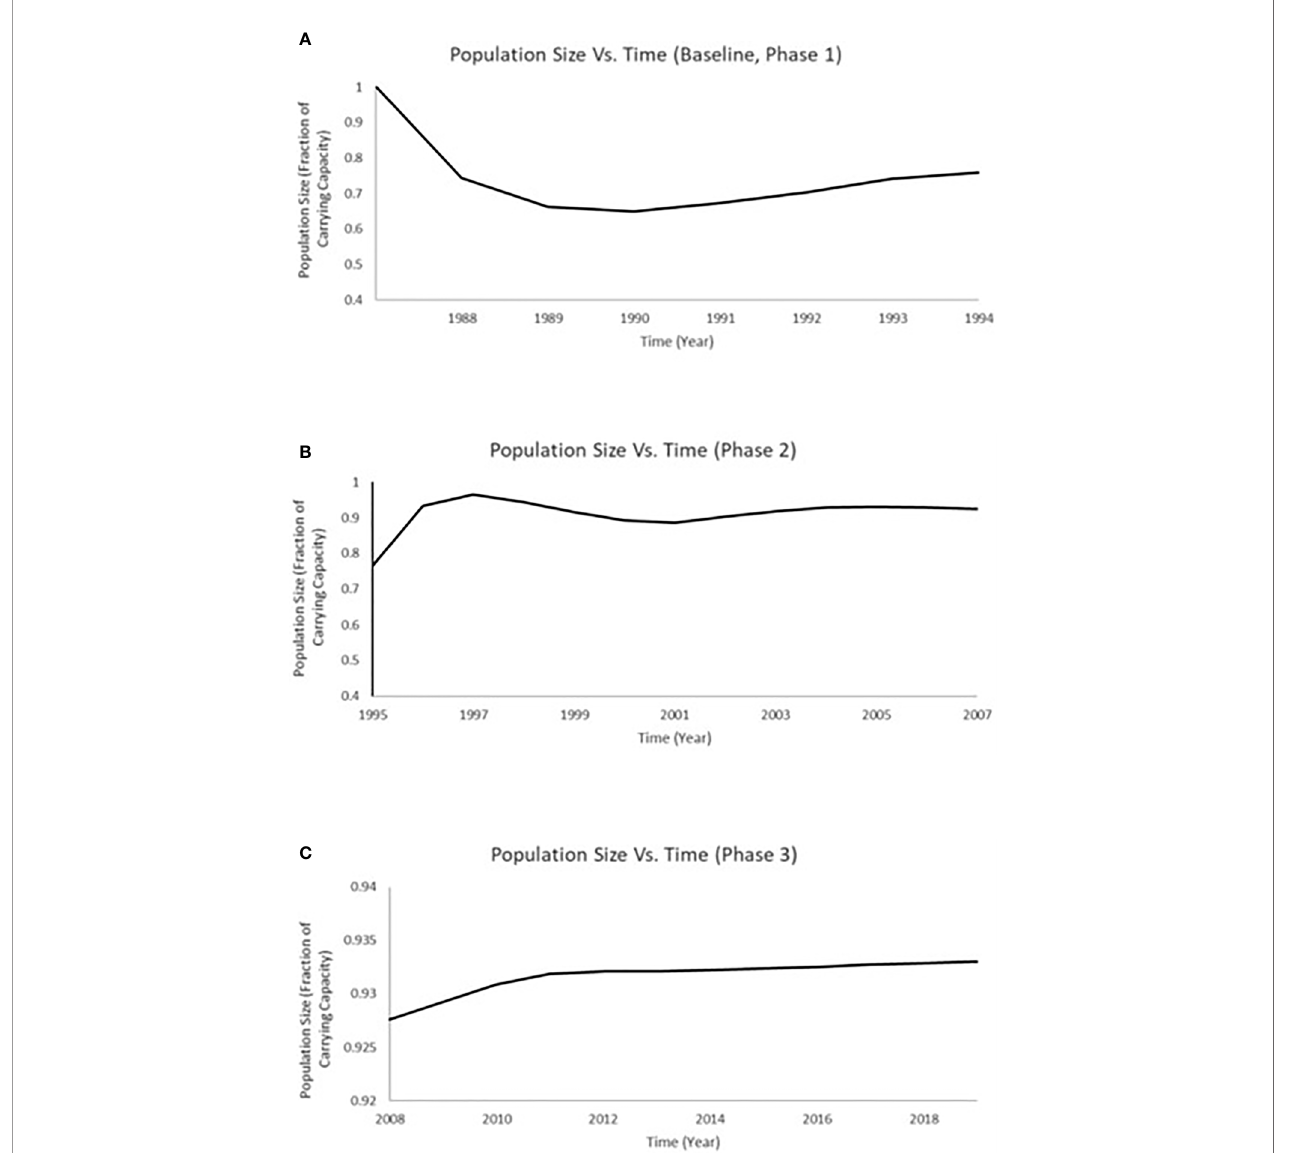
FIGURE 6 | Time series of total population size for white sucker at JFB that includes the timeframe of 1988 through 2019. (A) The predictions for total population size at JFB from Miller et al. (8) for the years 1988 to 1995 (which includes both baseline and Phase 1); (B) The predictions for total population size at JFB modeled for 1996 – 2007 (Phase 2); (C) The predictions for total population at JFB modeled for 2008 to 2018 (Phase